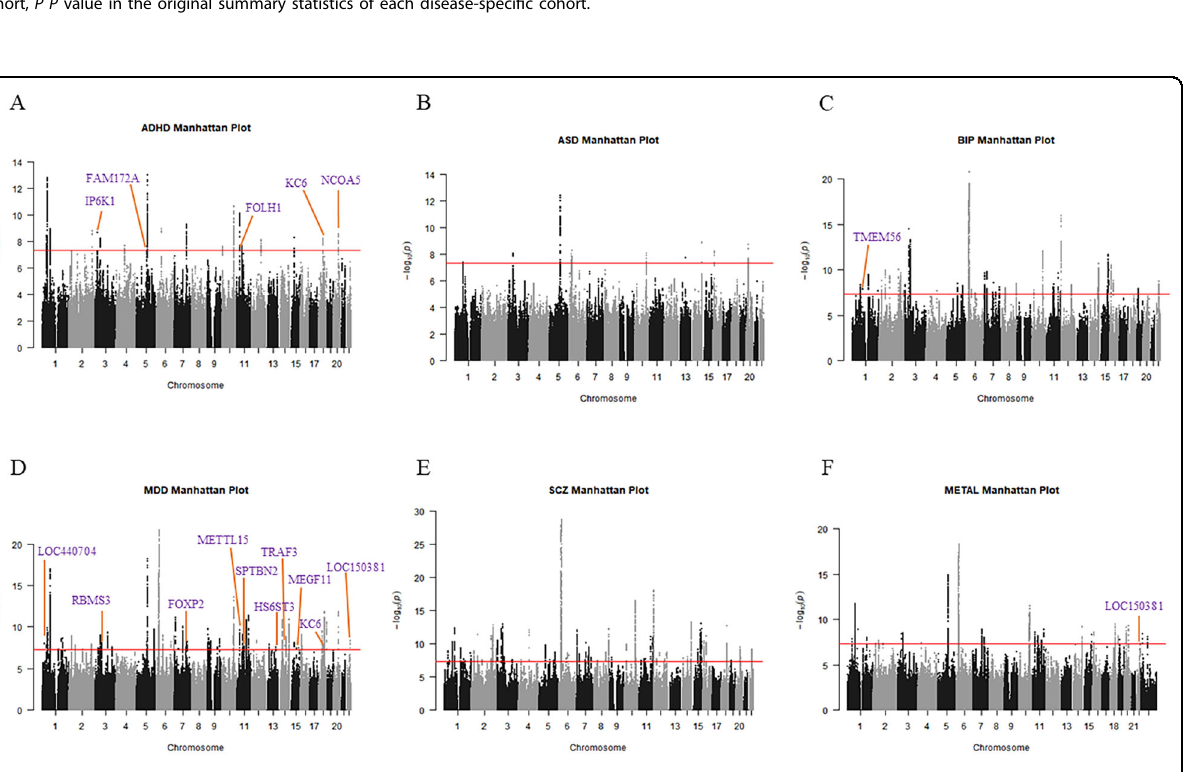
Chr chromosome, POS the position of each SNP on the human genome build hg19, SNP the most signi fi cantly associated SNP at each locus, A1 the effect allele, A2 the reference allele, META_P P value in the meta-analysis, Direction summary of effect direction for each study, with one “ + ” or “ − ” per the study, and “ + ” indicates A1 allele confers risk effect while “ − ” indicates A1 allele confers protective effect, Gene closest gene; disease the name of fi ve neuropsychiatric disorders, ADHD attention de fi cit hyperactivity disorder, ASD autism spectrum disorder, BIP bipolar disorder, MDD major depression disorder, SCZ schizophrenia, Beta the association coef fi